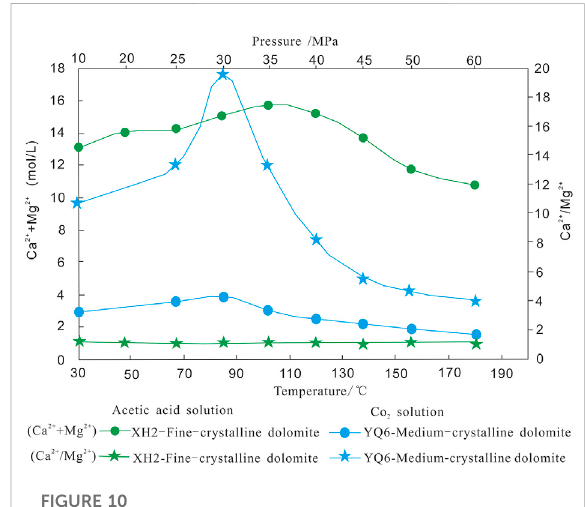
FIGURE 10 Variation trend ofdissolution results of fi ne-grained dolomite and medium-dolomite with temperature and pressure.